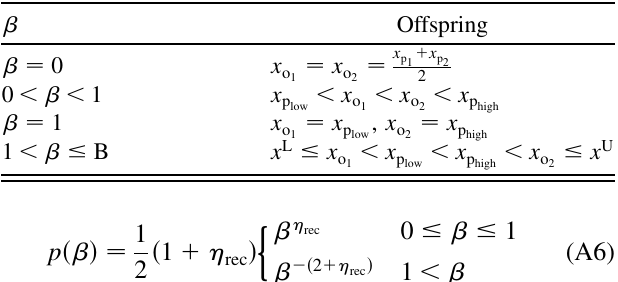
TABLE V. Correspondence for SBX between (cid:2) and offspring The effect of the tuning parameter (cid:7) ; x ; x ¼ min ð x Þ and x ¼ max ð x Þ . In produced for x influence of the polynomial mutation parameter (cid:7) p low p 1 p 2 p high p 1 p 2 (cid:7) the unbounded case, B ¼ þ1 , x L ¼ (cid:1)1 , and x U ¼ þ1 . For is increased, the variation decreases producing off- rec the bounded case, B is defined in Eqs. (A7) and (A8) while x L spring closer to the parent values. As (cid:7) and x U are defined in the optimization problem ð (cid:2) (cid:1) 1 Þ turning off recombination since approaches (cid:5) D (cid:2)